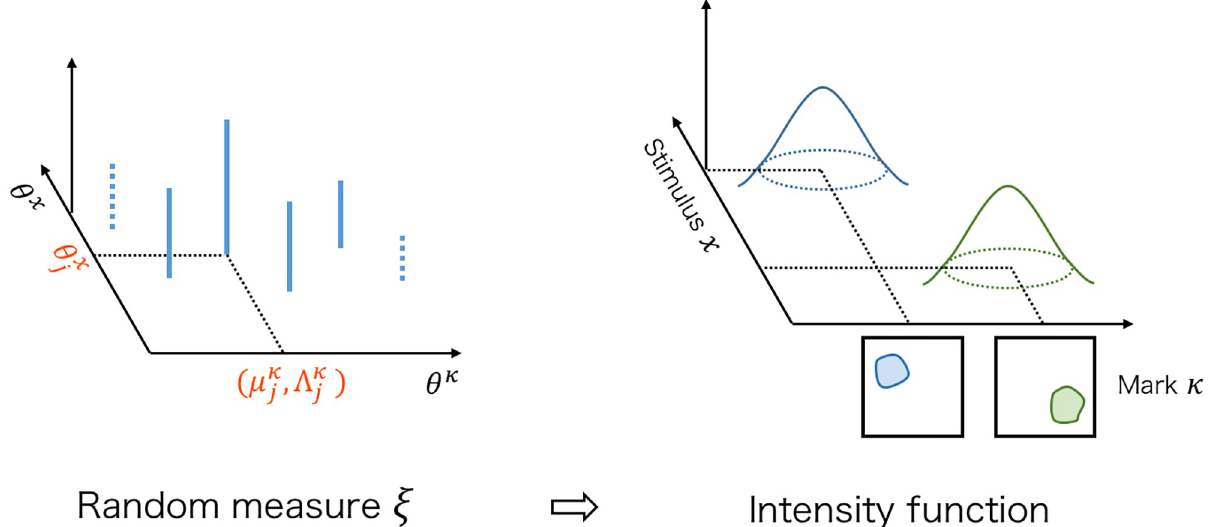
Fig 11. Prior. Intensity function λ ( κ j x , ξ ) is expressed as the sum of kernels, and it is indexed by the discrete measure ξ defined on Θ κ × Θ x . This discrete measure ξ consists of atoms fð m k fluorescent images, and the tuning curve parameter of each neuron. A weight attached to each atom expresses the average firing rate of this neuron. We set the mixture of gamma processes G